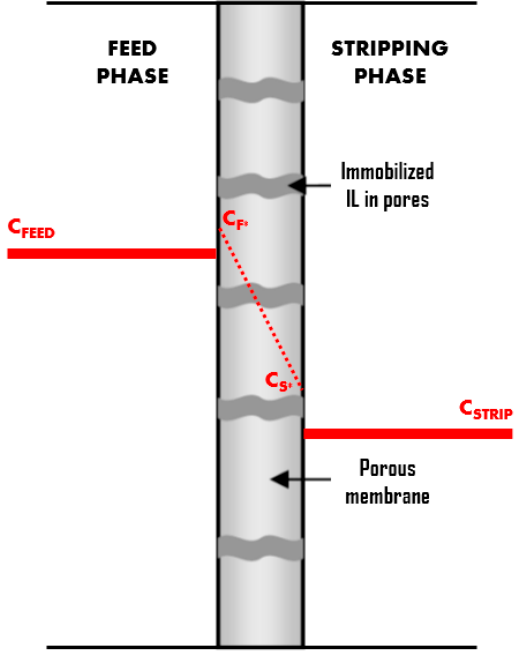
Figure 2. Schematic representation of transport through a SILM (Supported Ionic Liquid Membrane).